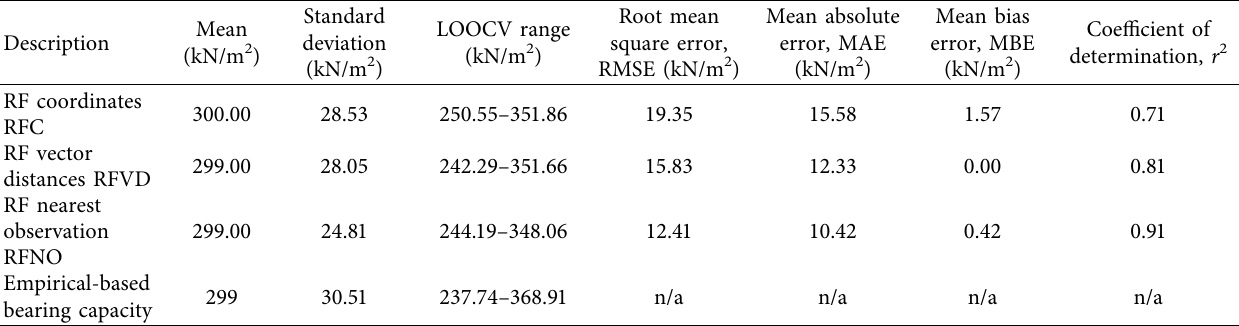
Table 3: Summary statistics for bearing capacities after dynamic compaction predicted using the machine learning spatial interpolation ML- SI and the empirical-based equation together with the measure of accuracy MOA obtained from LOOCV